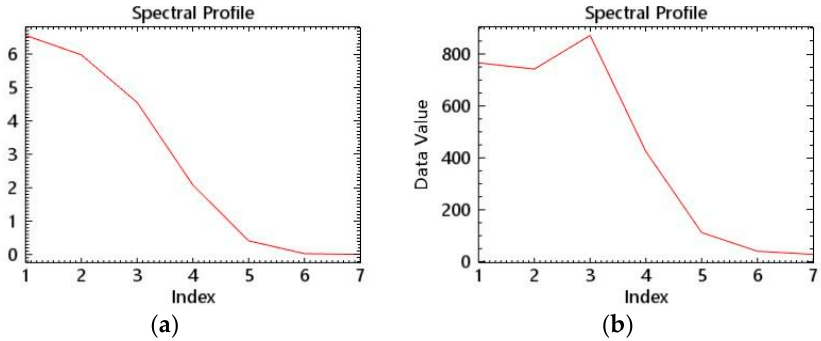
Figure 4. Spectral curves before and after atmospheric correction. ( a ) Before atmospheric correction. ( b ) After atmospheric